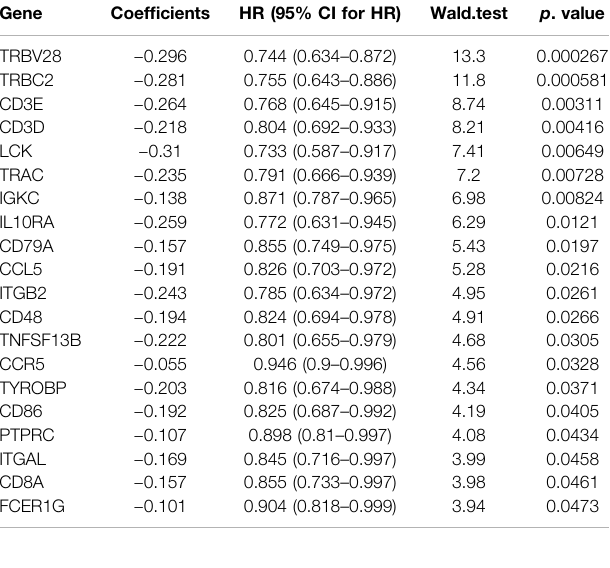
TABLE 2| Identi fi cation of20immune-related prognosticgenesbyunivariate Cox regression analysis. HR, hazard ratio; CI, Con fi dence interval.